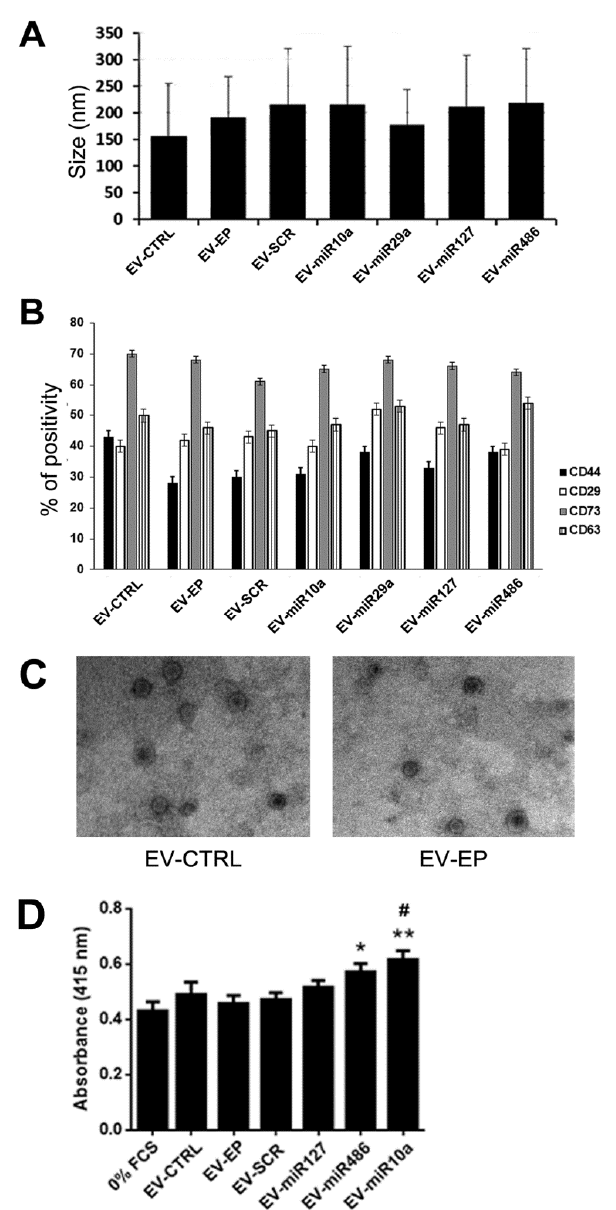
Figure 4. Characterization of EVs derived from naïve MSCs and from EP MSCs. ( A ) Size of EVs obtained from naïve MSC (EV-CTRL), from electroporated MSC (EV-EP) and transfected with scramble (EV-SCR) or with di ff erent miRNA mimics (EV-mir10a, EV-miR29a, EV-miR127, EV-miR486), evaluated by nanoparticle tracking analysis (NTA). Data reported are mean ± SD for three di ff erent experiments. No statistically significant di ff erences were observed among the di ff erent types of EVs; ( B ) cytofluorimetric analysis of the expression of MSC (CD44, CD29 and CD73) and exosomal (CD63) markers, in di ff erent EV populations. Data reported are the mean ± SD for three di ff erent experiments. No statistically significant di ff erences were observed in marker expression among the di ff erent types of EVs; ( C ) representative micrographs of transmission electron microscopy of EV-CTRL (left) and EV-EP (right). EVs negatively stained with NanoVan (magnification × 100,000); and ( D ) di ff erent types of EVs (1000 / cells) were added to mTECs maintained for 48 h in hypoxia, after which proliferation was evaluated following 24 h of reoxygenation. Data are reported as mean ± SEM for three di ff erent experiments in quadruplicate. ANOVA with Dunnett’s multiple comparison test was performed. ** p < 0.01 and * p < 0.05 mTEC stimulated with EV-mimic vs. mTEC maintained in 0% FCS, # p < 0.05 EV-miR10a vs. mTEC stimulated with EV-EP.